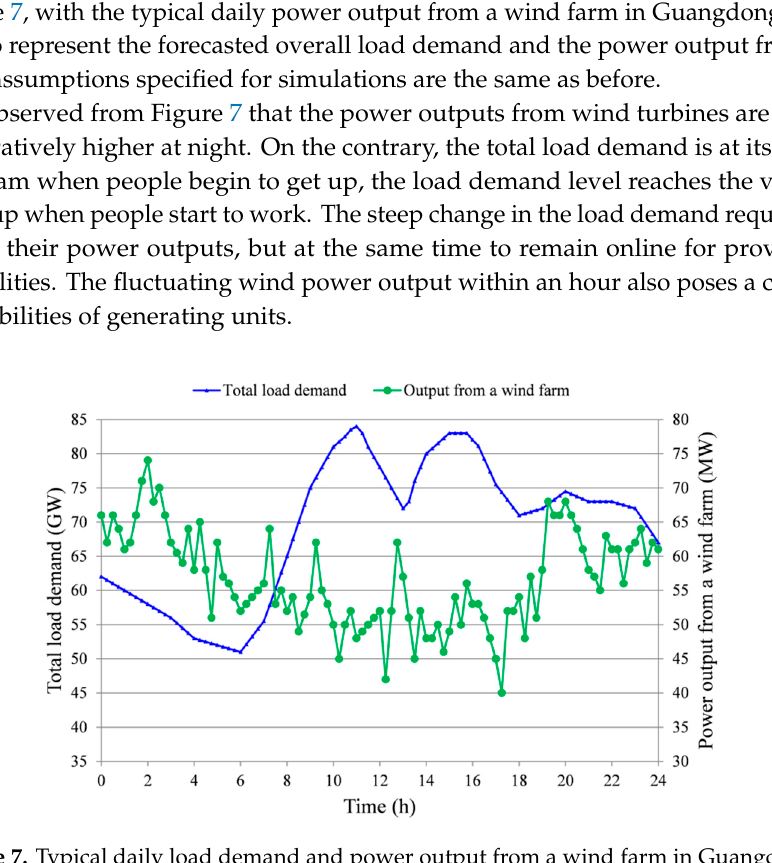
Table 6. Simulation results with and without FRP.